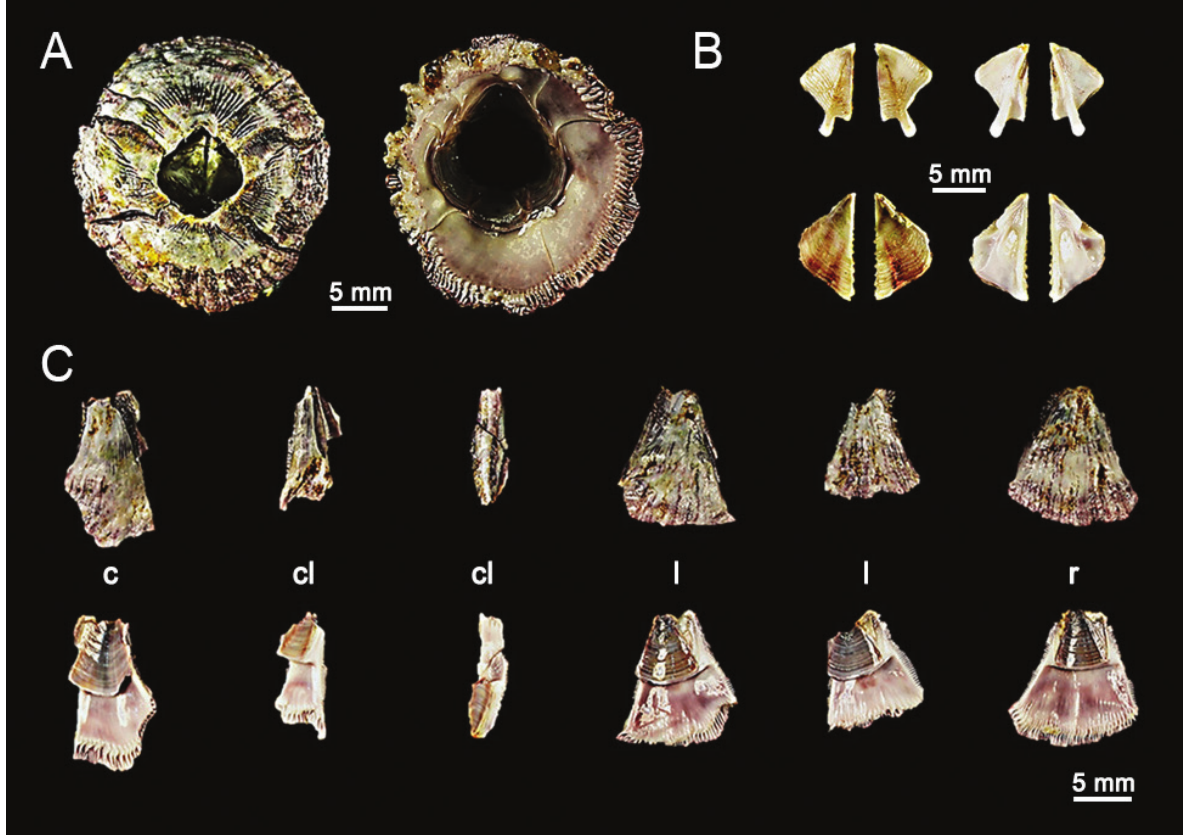
external shell, B. External (left panel) and internal (right panel) view of tergum (upper panel) and scutum (lower panel), C. External (upper panel) and internal (lower panel) view of shell plates. Abbreviations: c, carina; cl, carinal latus; l, latus; r,